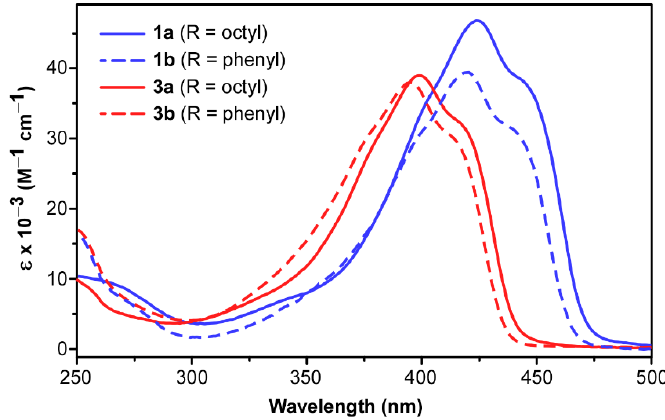
Figure 8. Solution UV-vis spectra of PBTz oligomers 1a , 1b , 3a , and 3b .